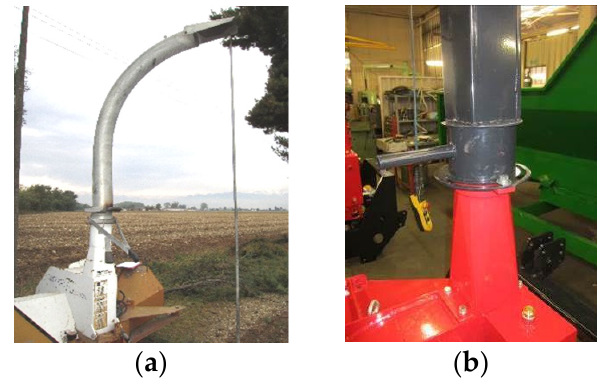
Figure 8. In some of the study cases ( a ) and ( b ), the discharge chute could be fully rotated, therefore well beyond the limit defined by the standard draft.